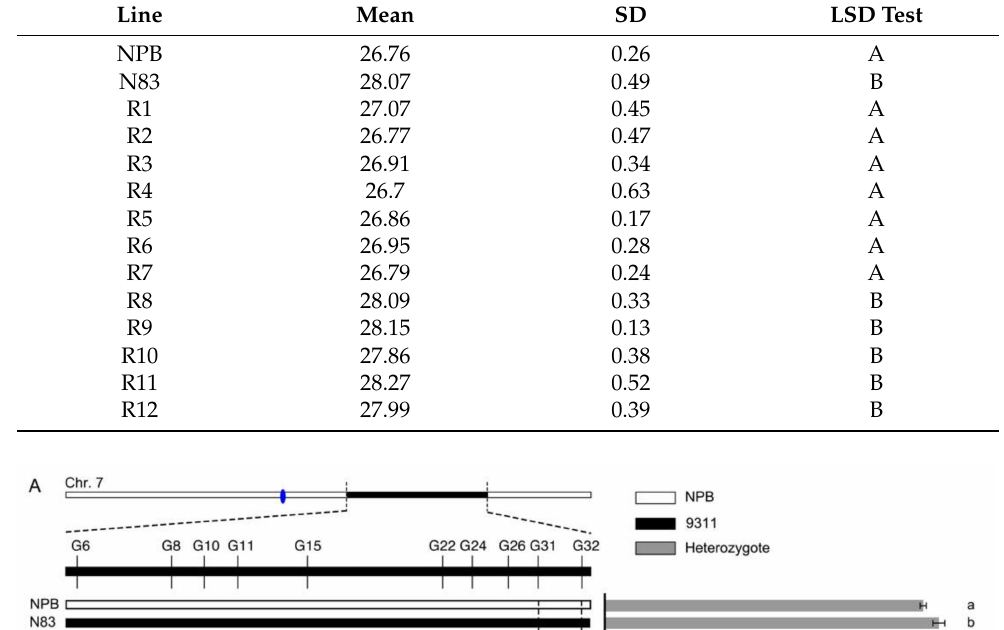
Table 5. Phenotypic performance of TGW in twelve NILs in BC 9 F 5 .